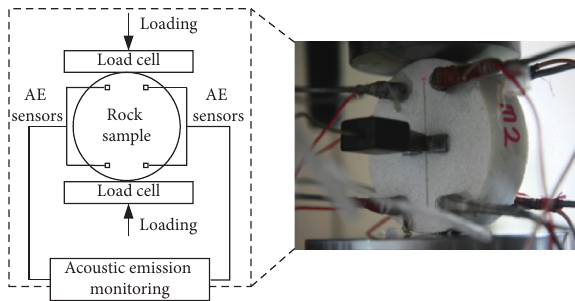
Figure 2: Schematic diagram of acoustic emission monitoring.